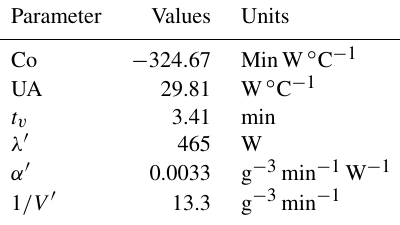
Table 2. Fuzzy Tuning Table for Kdp of PID Controller.